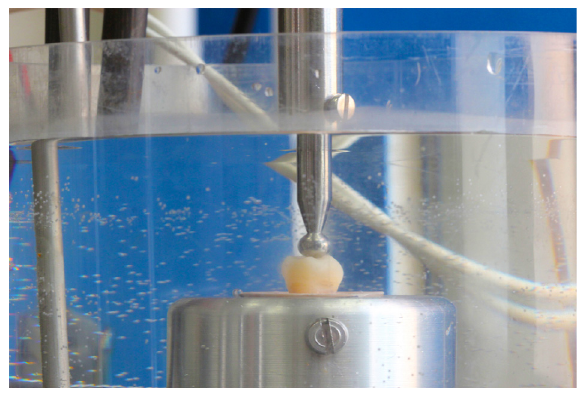
Figure 2. Specimen attached to the platform and submerged in distilled water, with the metal ball positioned in the center of the tooth for fatigue